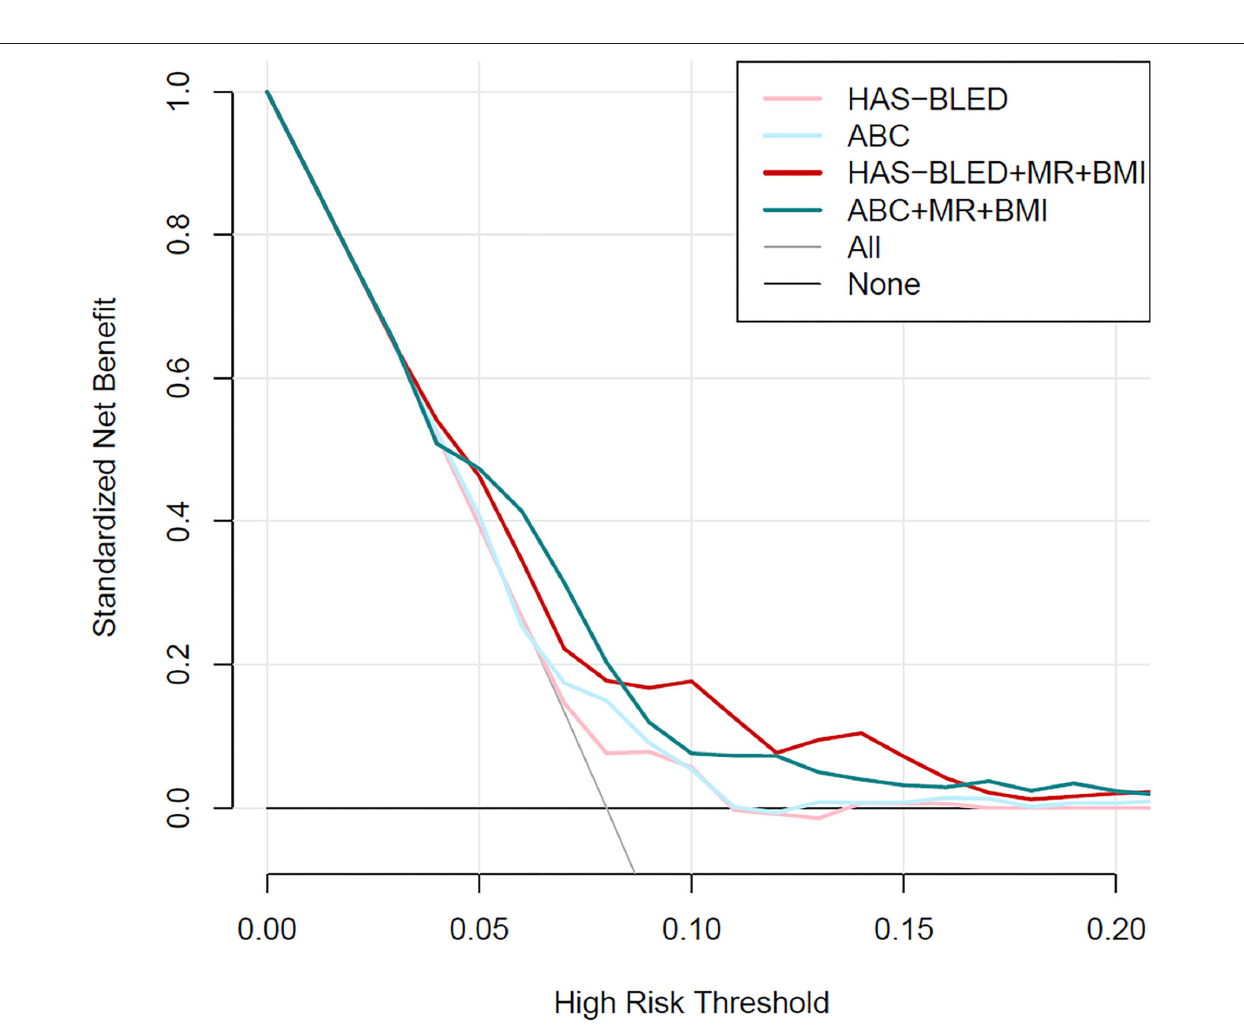
Frontiers in Cardiovascular Medicine |